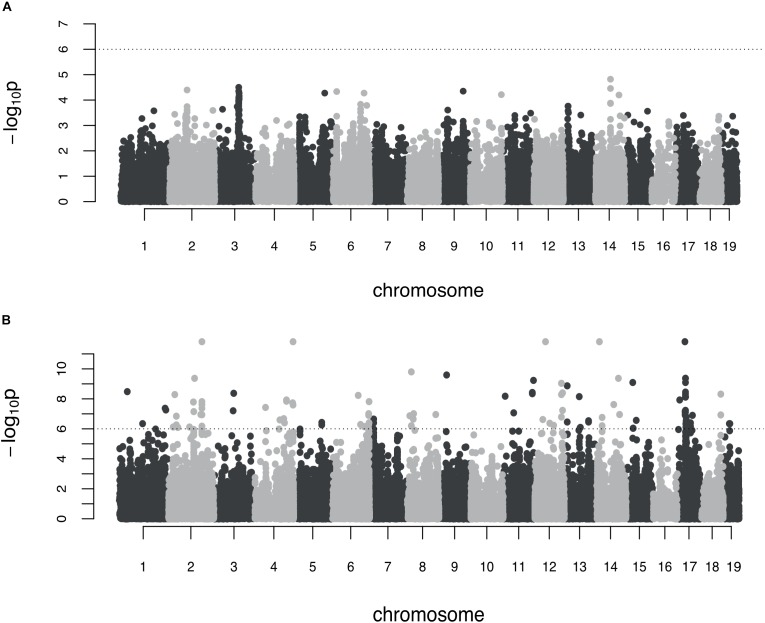
Genome-wide association on the symmetric shape variance (environmental canalization). (A) Additive genome scan. Each dot corresponds to the LOD score of one marker and the dashed line represents the significance threshold; (B) marginal epistasis genome scan (Davies method). The dashed line corresponds to the threshold set to select marker for subsequent pairwise analyses.